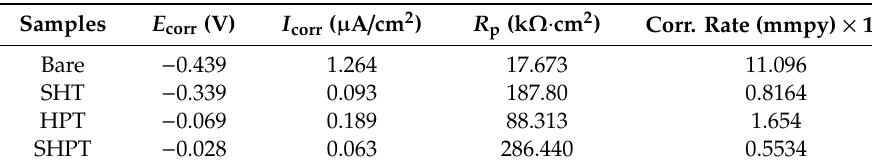
Table 2. LPR parameters of bare and treated TNZ specimens.